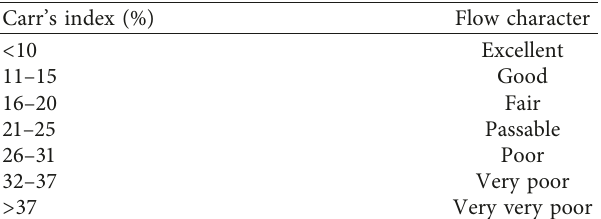
Table 3: Effect of Carr’s index on flow character.